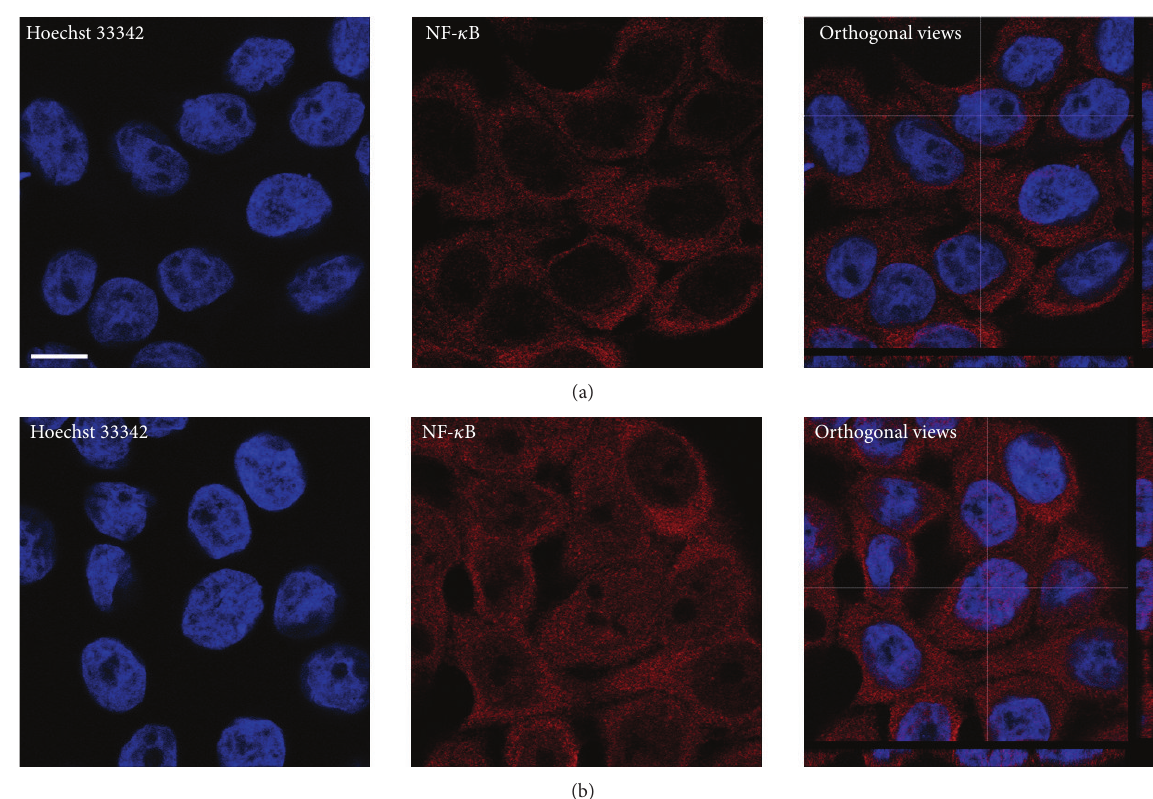
Figure 6: TNF- 𝛼 induced NF- 𝜅 B translocation into the nucleus. Using an anti-p65 primary antibody, NF- 𝜅 B was detected in HT-29-NF- 𝜅 B- hrGFP E5 cells. Cells were stimulated with TNF- 𝛼 (50 ng/mL) during 1h, nonstimulated cells were used as control. Nuclei were stained with Hoescht 33342 (blue). Nonstimulated cells show only NF- 𝜅 B (red) in their cytoplasm (a); meanwhile, in stimulated cells NF- 𝜅 B is present both in the cytoplasm and nucleus (b). Scale bar = 10 𝜇